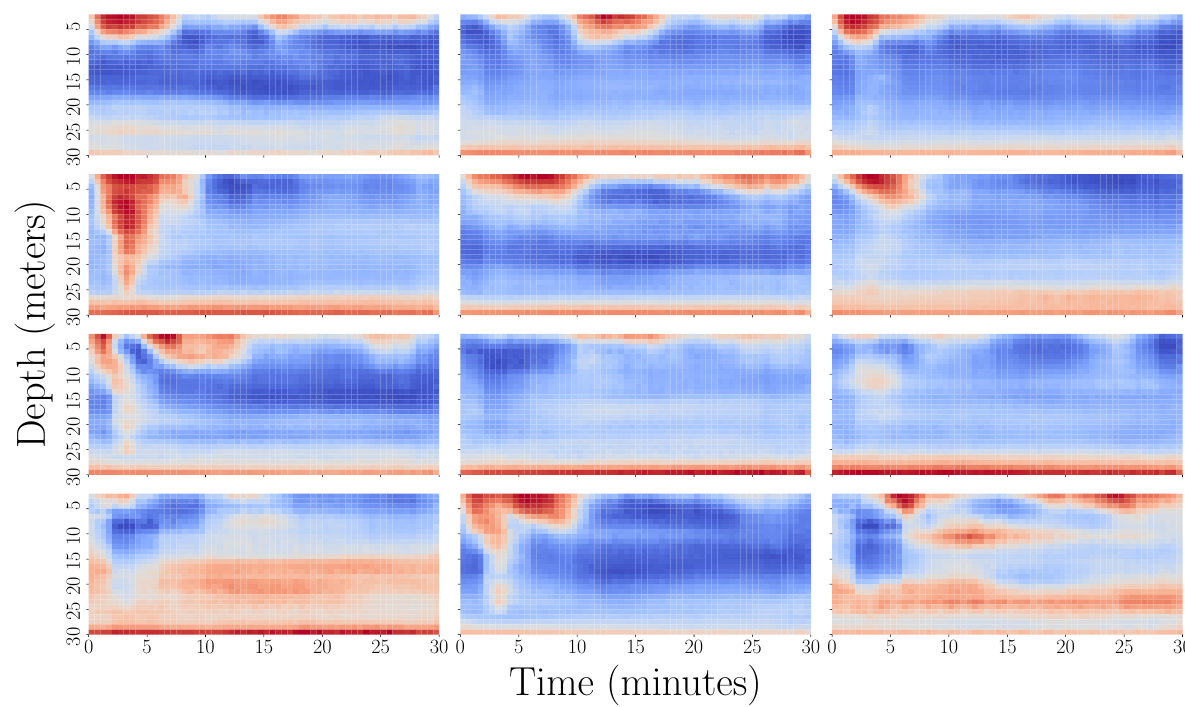
Figure 7. Wake frames generated using GMM and